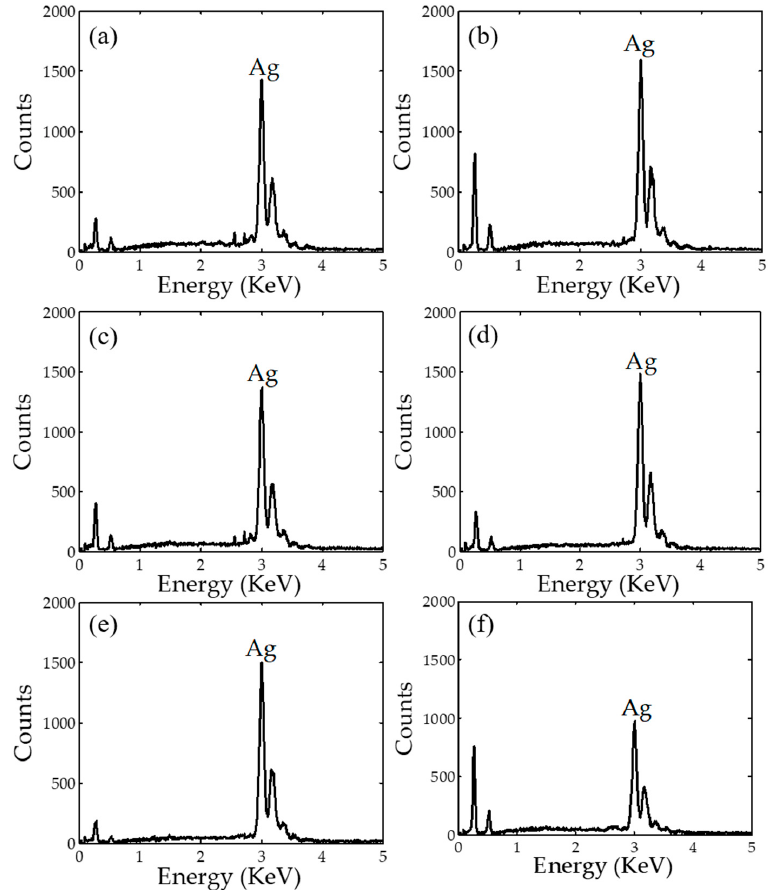
Figure 5. Energy-dispersive X-ray spectroscopy (EDX spectra) of AgNPs synthesized using ( a ) Cyperus rotundus ; ( b ) Eleusin indica ; ( c ) Euphorbia hirta ; ( d ) Melastoma Malabathricum ; ( e ) Clidemia hirta ; and ( f ) Pachyrhizus erosus